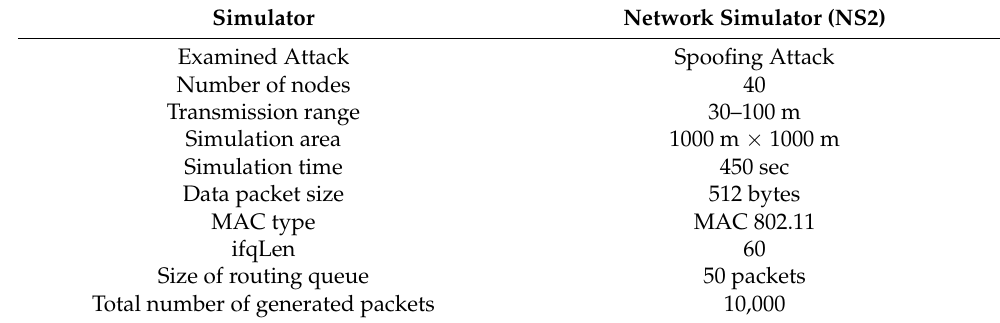
Table 4. Simulation